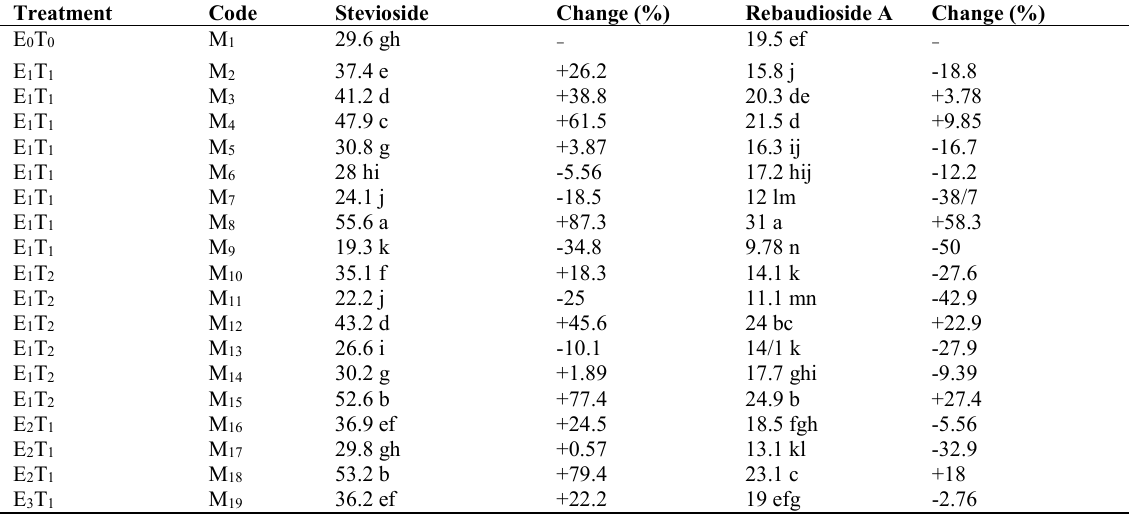
In each column, means that have at least one letter in common didn’t show any significance difference. + and – indicates percentage of increase and decrease than